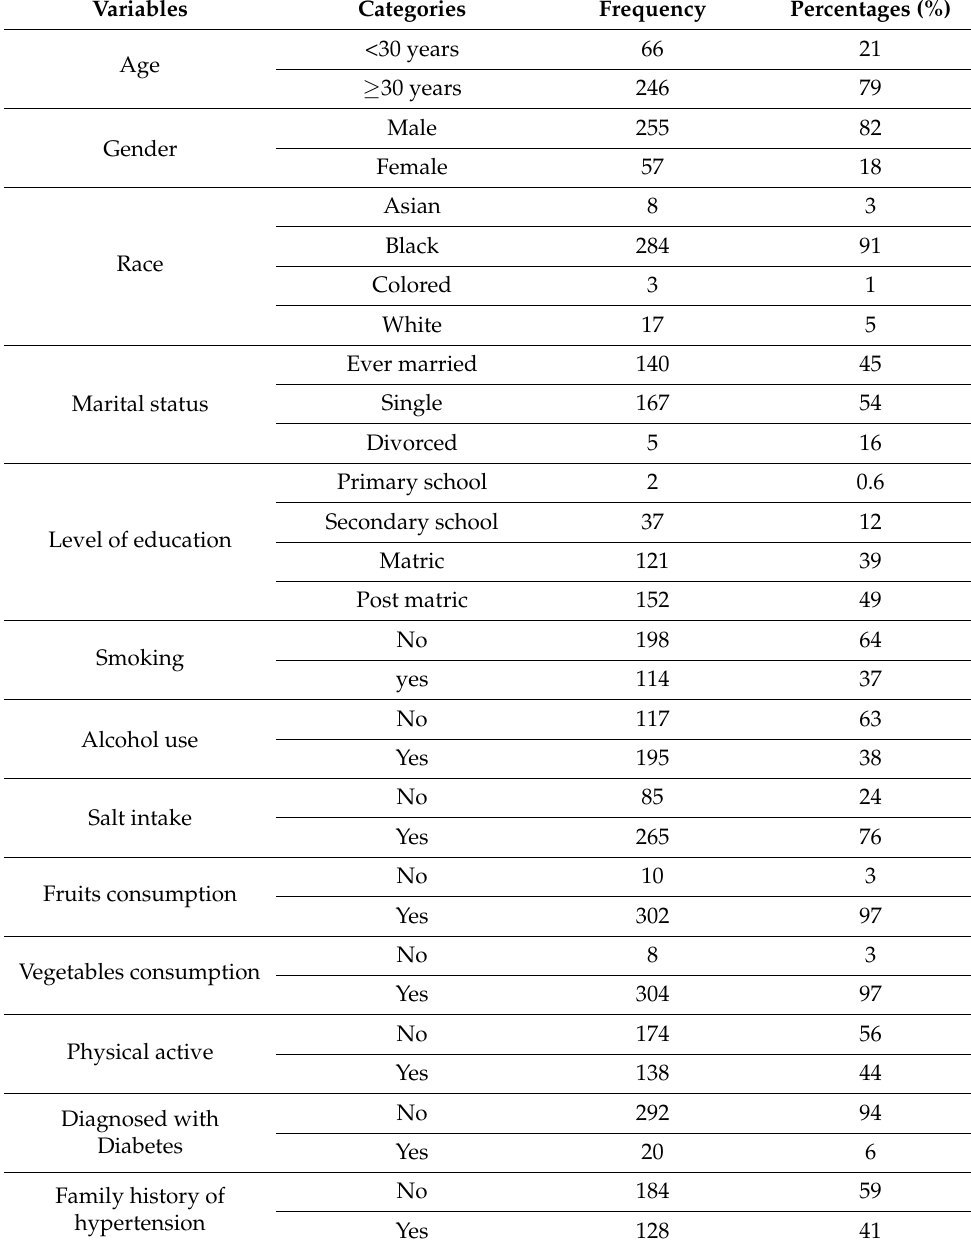
Table 1. Selected demographic variables and lifestyle